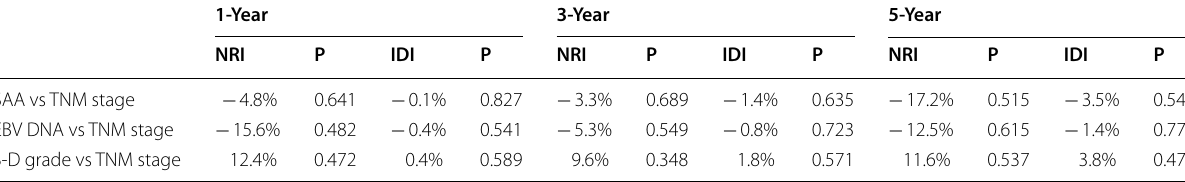
EBV DNA with TNM stage using NRI and IDI a +